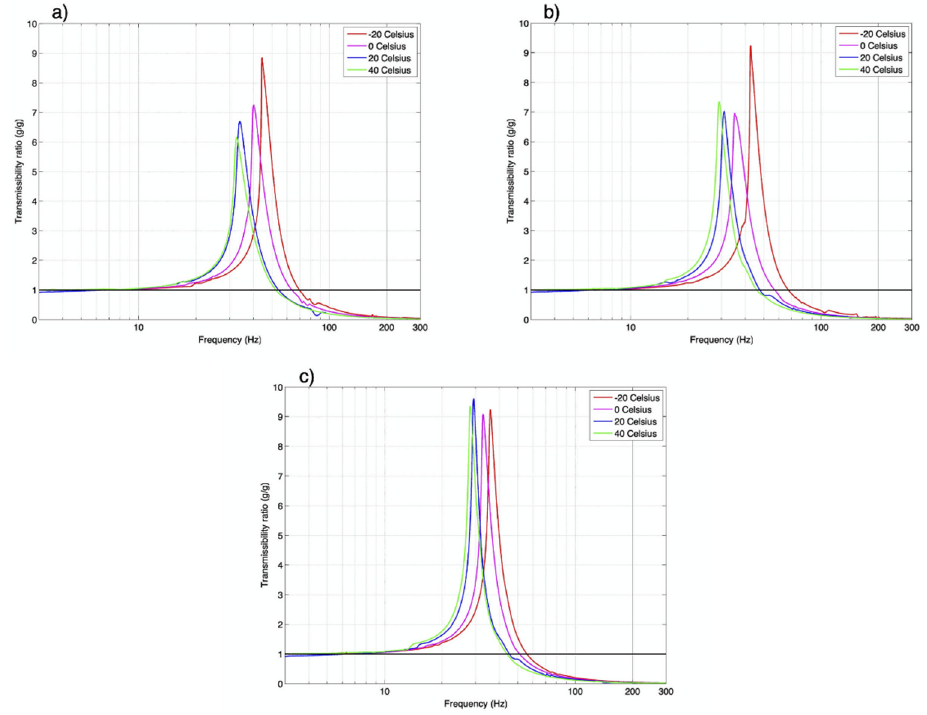
Figure 7. Vibration transmissibility and frequency curves for ( a ) PE25 at a static load of 3.488 kPa, ( b ) PE25 at a static load of 4.651 kPa, and ( c ) PE25 at a static load of 6.976 kPa (frequency is in logarithmic scale).